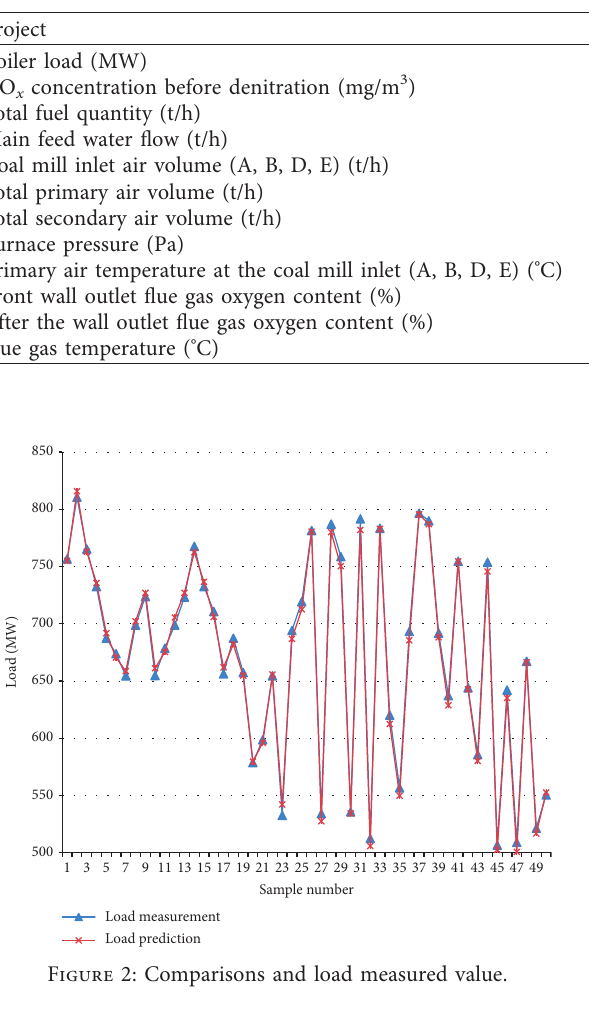
Table 3: Overview of experimental data.